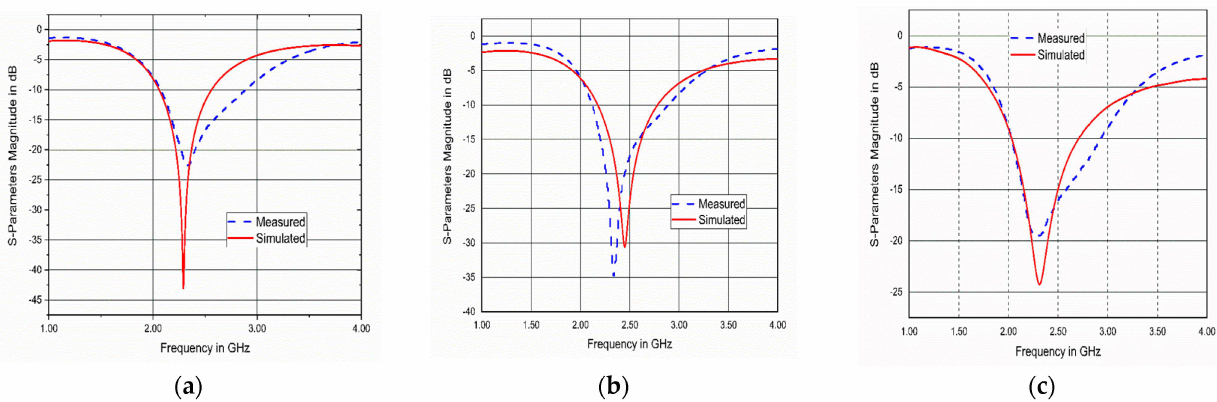
Figure 17. Simulated and measured reflection coefficients of the implanted antenna in different scenarios: ( a ) muscle; ( b ) liver; ( c )